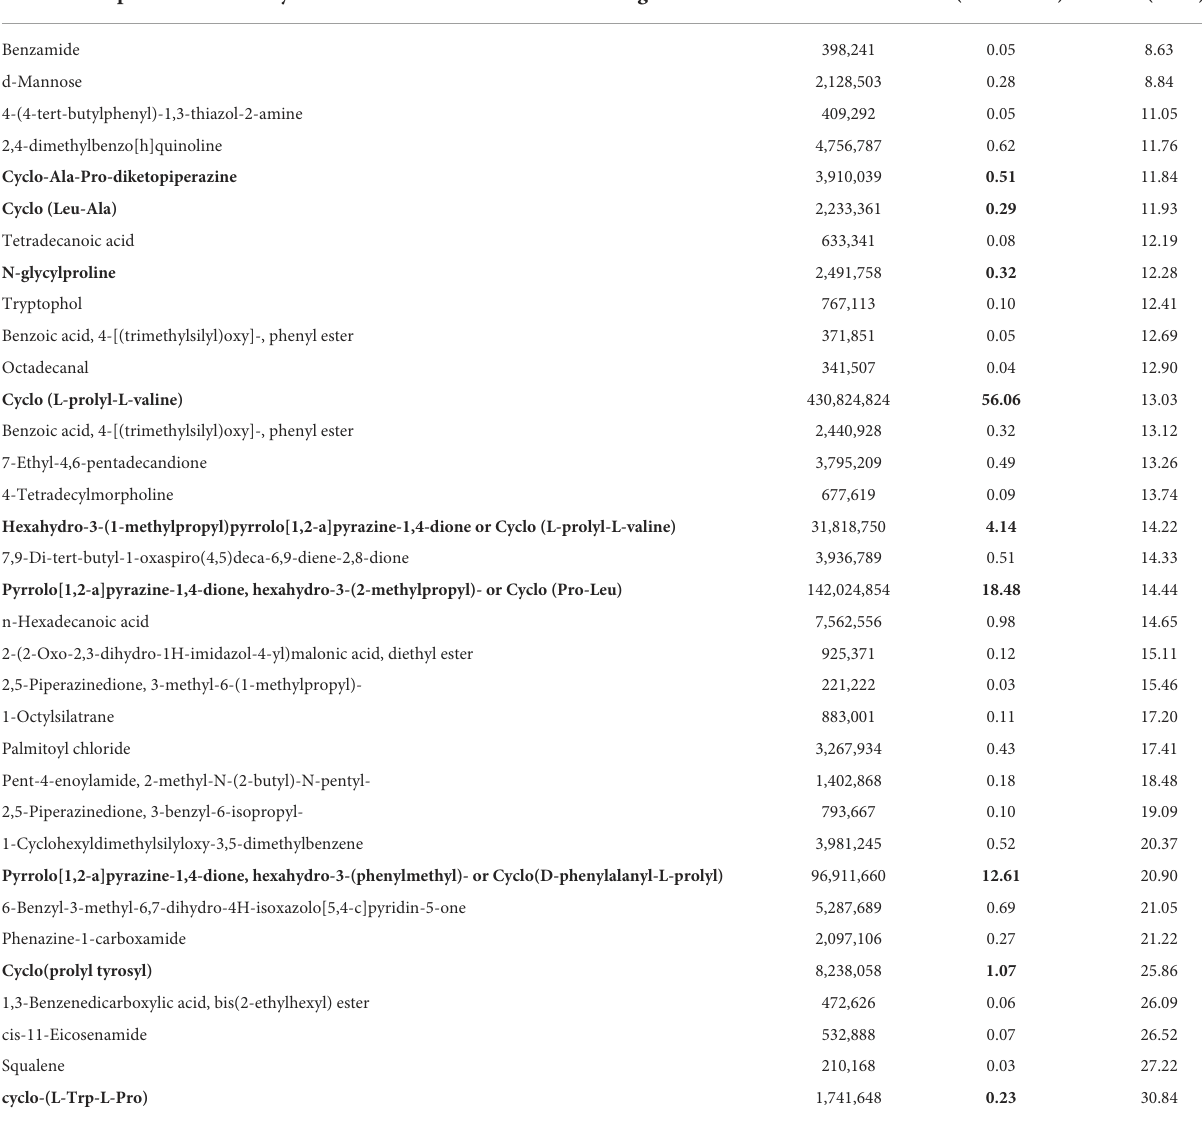
TABLE 3 Metabolite present in the ethyl acetate extract of Pseudomonas aeruginosa RKC1. Metabolites present in the ethyl acetate extract of Pseudomonas aeruginosa RKC1 Area %(Total area) RT